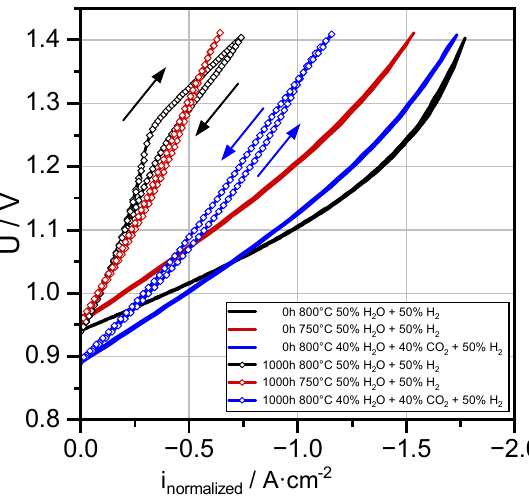
Figure 2. Comparison of iV curves before and after the durability tests. For instance, at 800 ◦ C, the maximum current density was decreased by 1.03 A · cm − 2 for steam electrolysis and 0.59 A · cm − 2 in co-electrolysis conditions. At 750 ◦ C operating temperature, the cells’ current density decreased by 0.89 A · cm − 2 for steam electrolysis and less severely compared to the observed loss at 800 ◦ C. The comparison of the percentage performance decrease from the initial values at 800 ◦ C for steam (58%) and co-electrolysis (34%) emphasizes the crucial impact of the feed gas on cell performance over time. Long- term galvanostatic test results at − 0.75 A · cm − 2 at 750 ◦ C by Rao et al. [37] under co- electrolysis conditions showed a higher performance loss of around 50% · kh − 1 . The authors used a different gas composition of 65% H 2 O + 25% CO 2 + 10% H 2 , i.e., with a higher steam content, which may cause the higher performance loss. After the degradation tests at 800 ◦ C, the iV curves for co-electrolysis and steam electrolysis displayed hysteresis. For steam electrolysis this hysteresis was more pronounced, so the hysteresis’s origin cannot be linked to the CO 2 in co-electrolysis, as suggested by Aicart [38], or low steam content [39], but to the operating temperature over time. To further understand the degradation behavior of the cells during three long-term tests, the area-specific resistance (ASR) was calculated from impedance measurements and plotted in Figure 3 as a function of testing time.